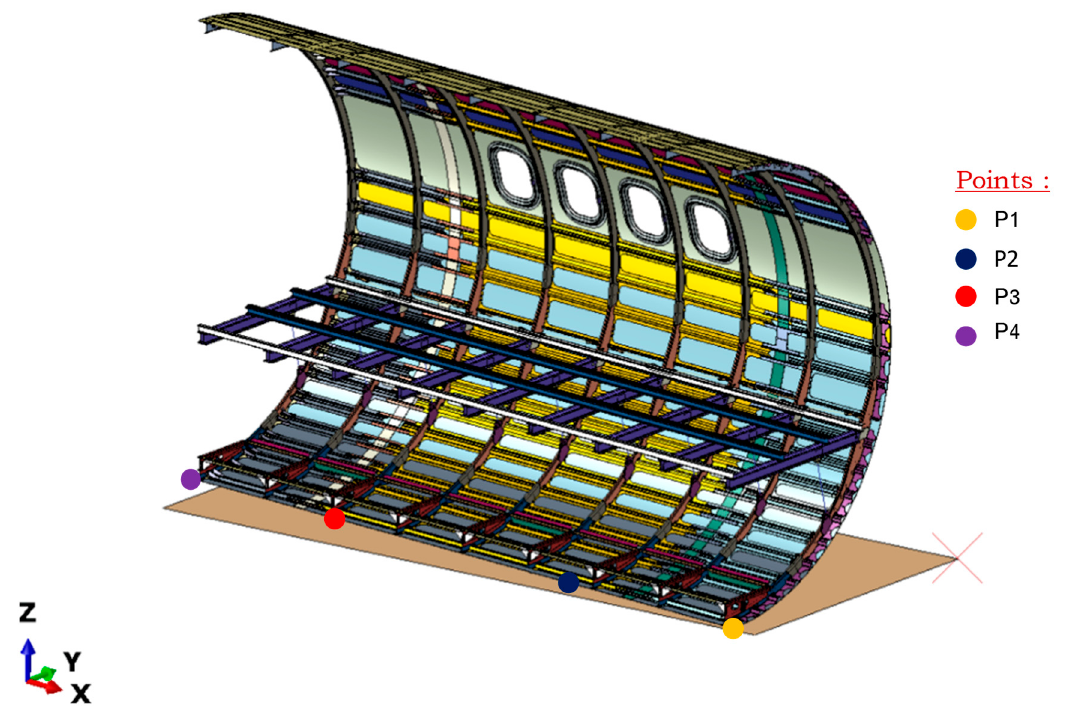
Figure 12. Node positions. Figure 12. Node